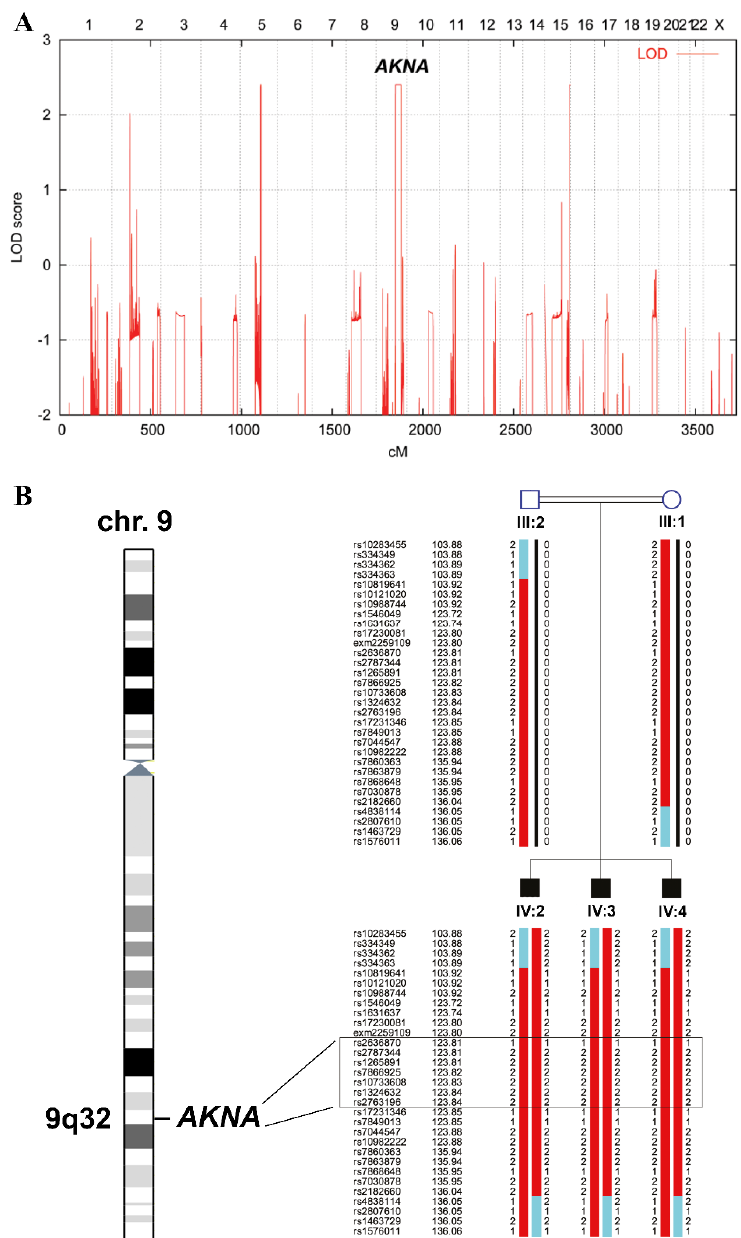
Figure 2. Mapping of a new locus for MCPH on chromosome 9. ( A ) Genome-wide LOD (logarithm of the odds) scores generated from SNP array data. A 25 K panel of equally distributed markers with a minor allele frequency higher than 0.10 was used. Scores are plotted over genetic distance across the genome according to the deCODE map. Chromosomes are concatenated from p-ter to q-ter from left to right. The highest scores were obtained for markers on chromosomes 5, 9 and 15 with the linkage signal on chromosome 9 at cytoband 9q32 representing by far the longest run of homozygosity. The LOD score was equal to 2.4, which is the theoretical maximum for this family assuming full informativity of the marker set. ( B ) Haplotypes of the linkage region on chromosome 9 including AKNA . The size of the homozygous region is 24.9 Mb. The heterozygous markers flanking this interval are rs334363 (101,928,702 bp) at 103.89 cM and rs4838114 (126,875,893 bp) at 136.05 cM, referring to build GRCh37.p13. SNP markers of the AKNA region are boxed.